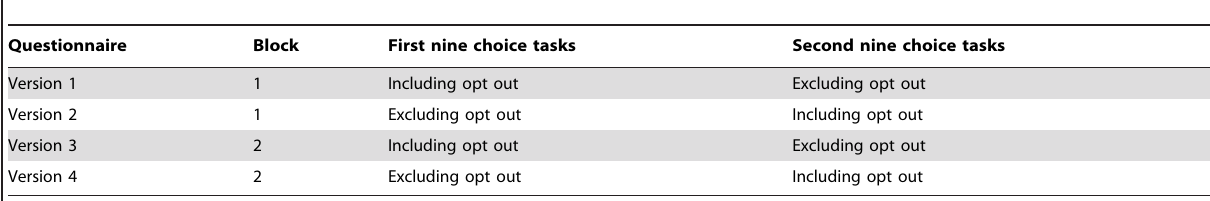
Table 1. Overview of the content of every version of the questionnaire.